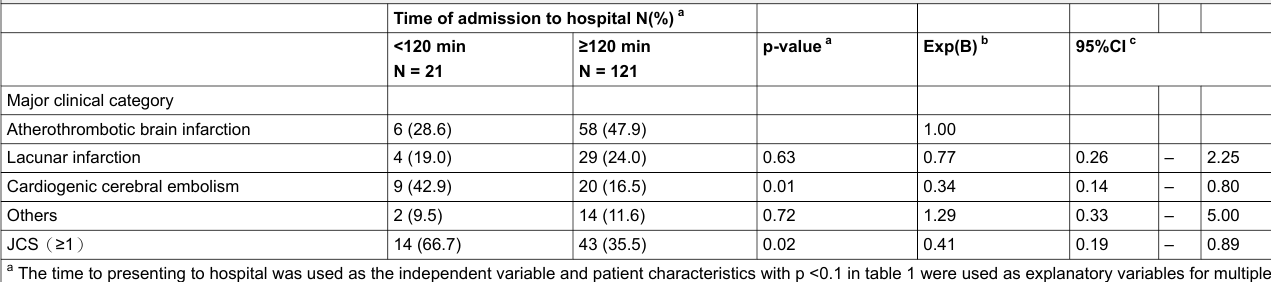
Table 4: Time to presenting to hospital and patient characteristics: Multivariate analysis using data of patients with a first stroke within a 32-km radius.